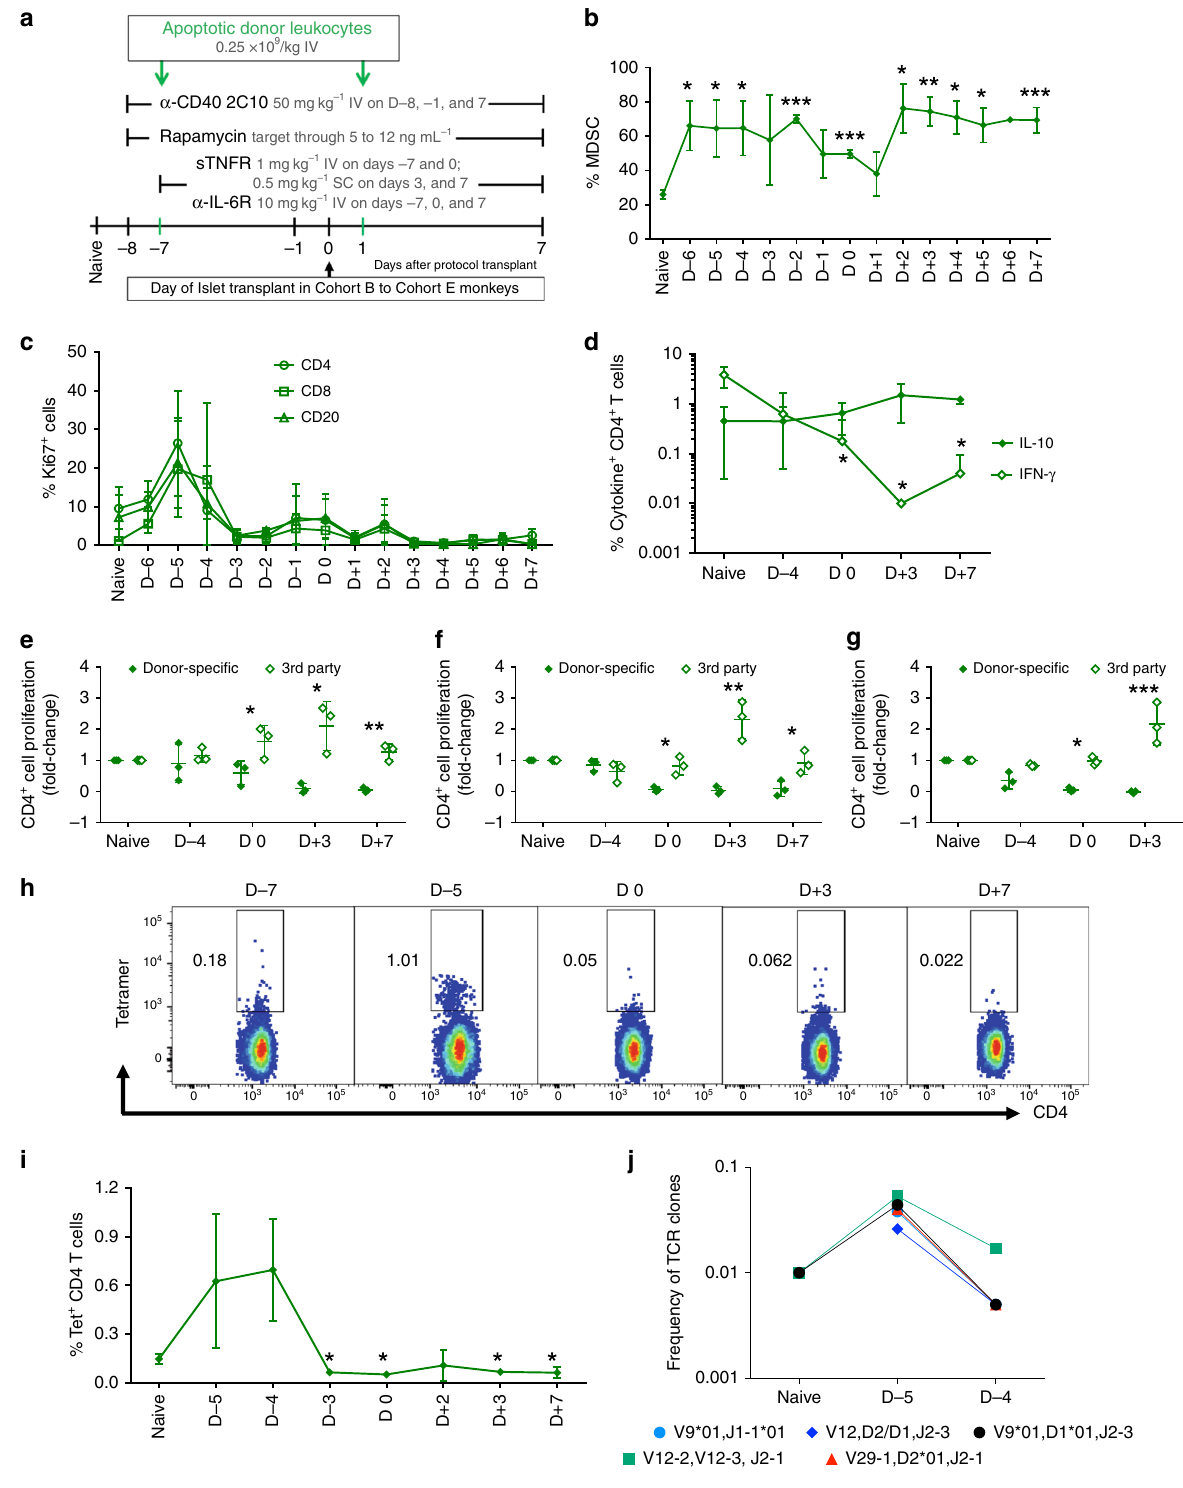
B monkeys on short-term immunosuppression, intraportal transplants of 8-day cultured islet allografts were accepted for ≥ 365 days (Fig. 2a, b). In 5 of the 5 Cohort C monkeys, ADL infusions added to short-term immunosuppression was associated with signi fi cantly improved survival; all 5 exhibited operational tolerance of islet allografts for ≥ 365 days post- transplant (Fig. 2a, b). Cohort C monkey #13EP5 became nor- moglycemic immediately posttransplant and remained so, even NATURE COMMUNICATIONS| (2019) 10:3495